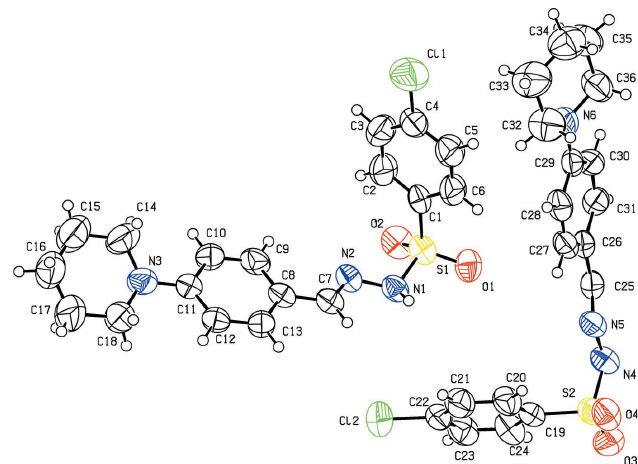
Figure 1 Molecular structure of (I), showing the atom labelling and displacement ellipsoids drawn at the 50% probability